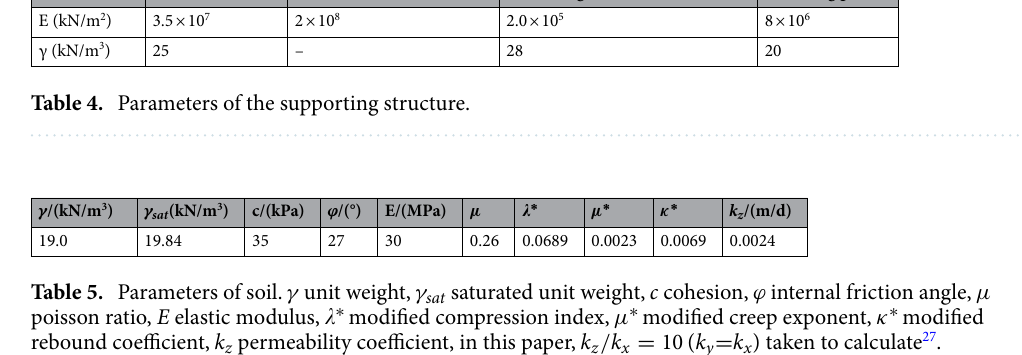
10 ( k y = k x ) taken to calculate 27 . =